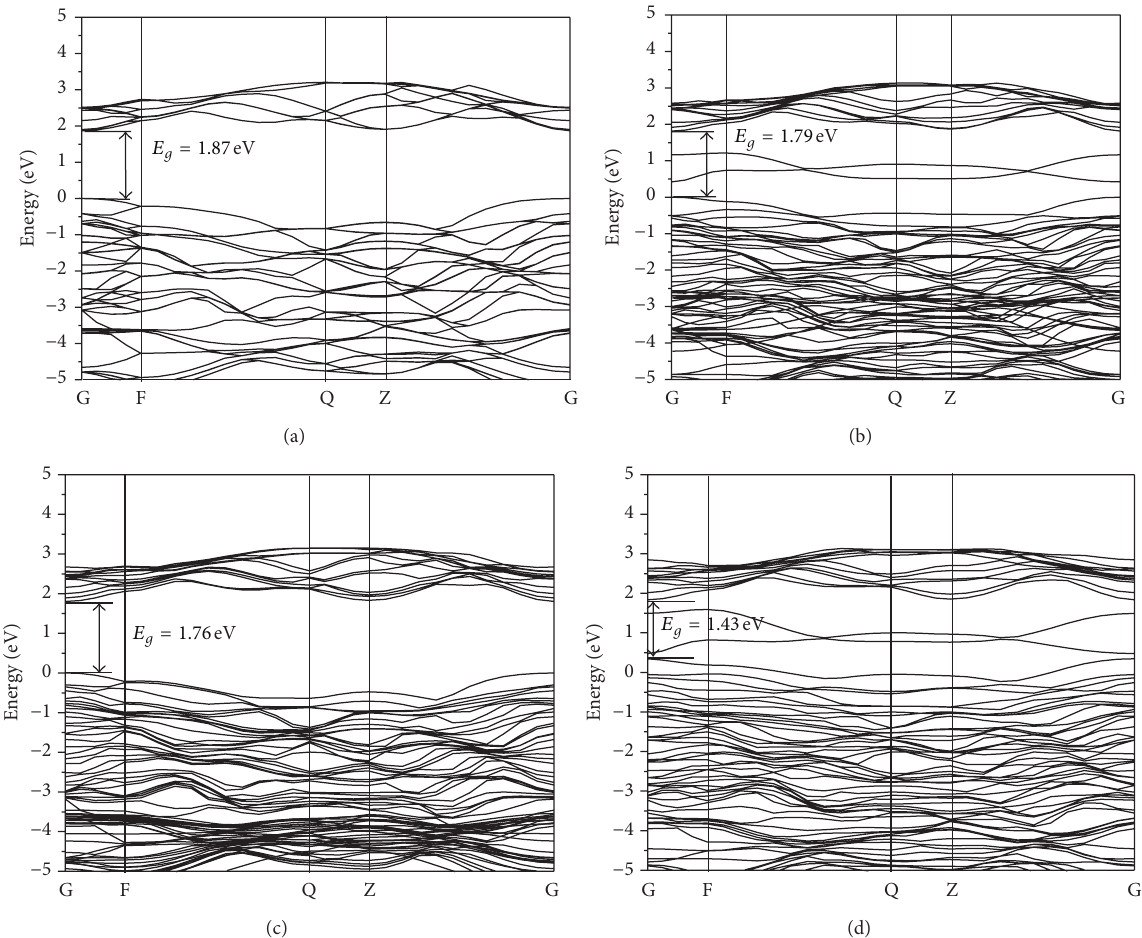
Figure 2: The calculated band structures of (a) pure rutile titanium dioxide, (b) Ni-doped rutile titanium dioxide, (c) N-doped rutile titanium dioxide, and (d) Ni + N-codoped rutile titanium